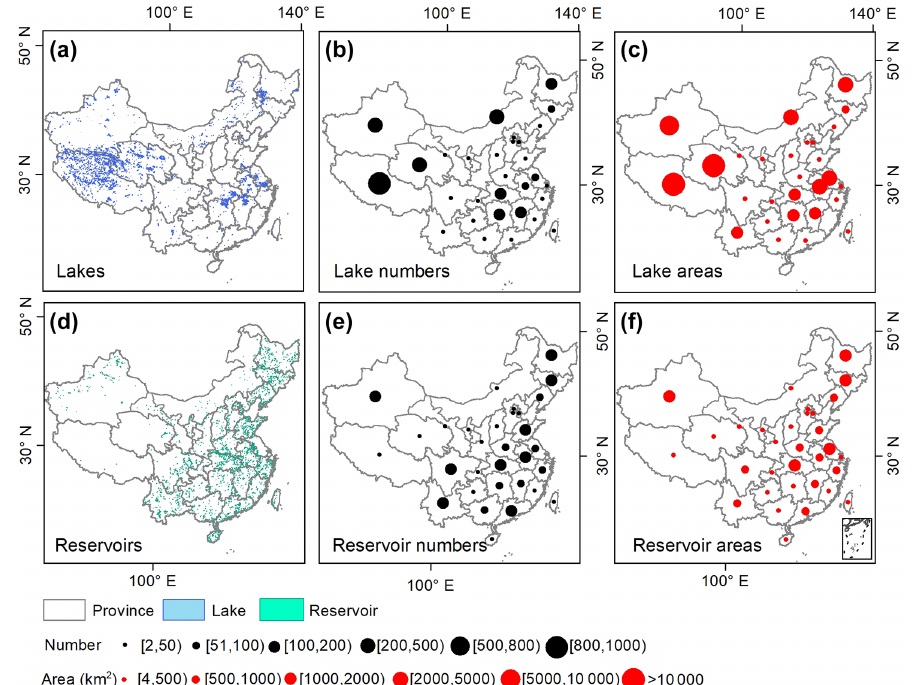
Figure 8. Numbers and areas of lakes and reservoirs in China for 2019. (a) Spatial distribution of lakes; (b) lake numbers by province; (c) lake areas by province; (d) spatial distribution of reservoirs; (e) reservoir numbers by province; and (f) reservoir areas by province.